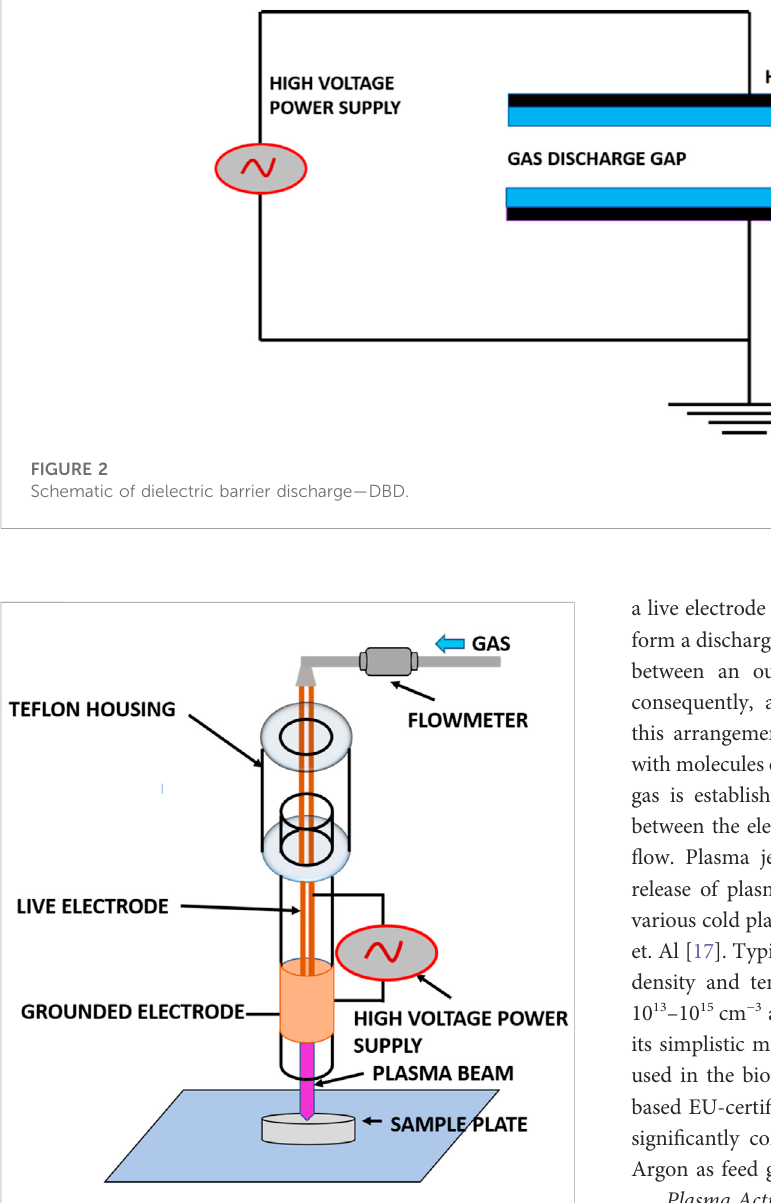
FIGURE 3 Laboratory set up of Cold plasma (CAP) at atmospheric